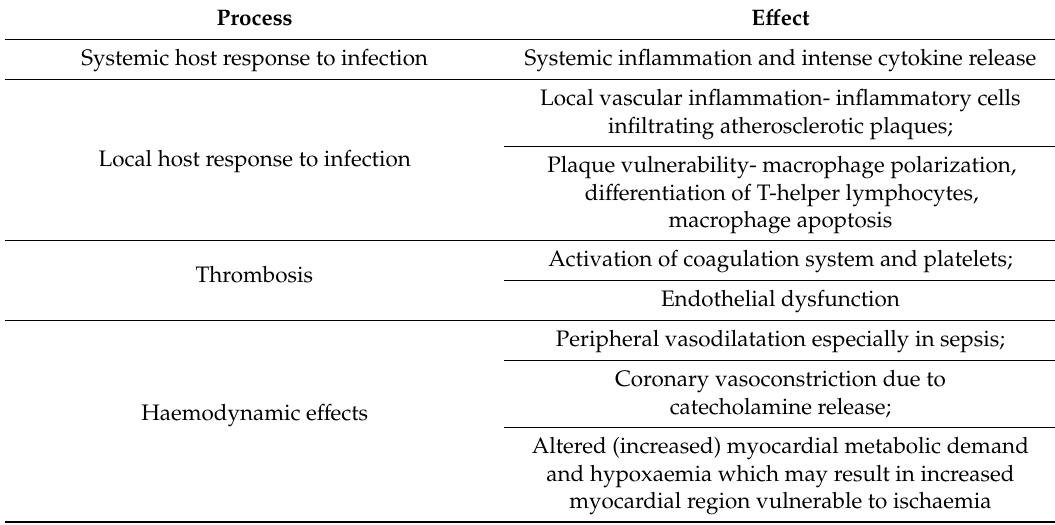
Table 1. Potential mechanisms that may trigger acute coronary syndrome during respiratory tract infection. Adapted from Bazaz et al.